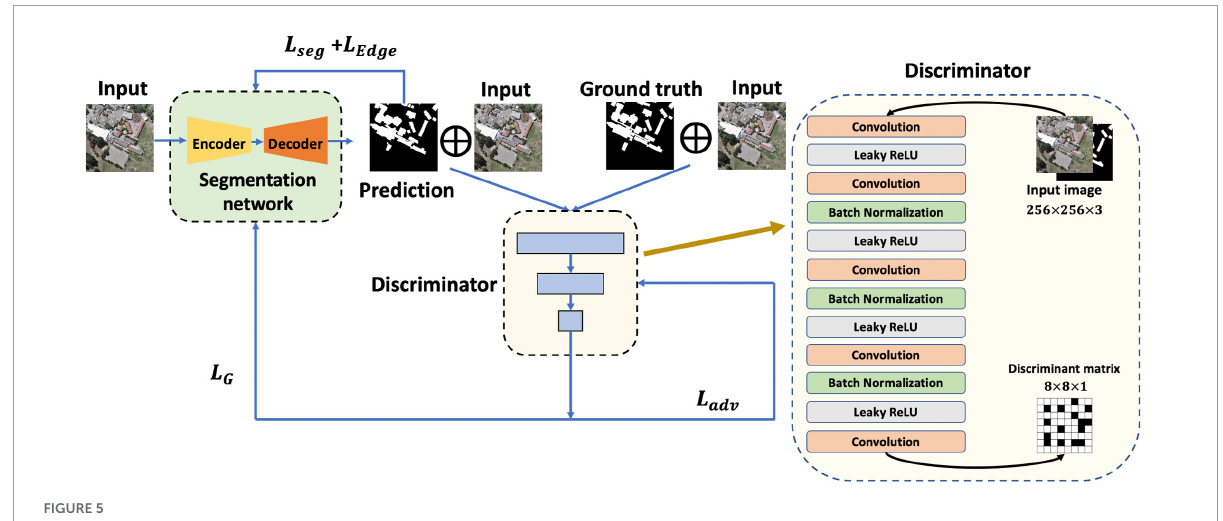
FIGURE5 Markovian discriminator and gradient